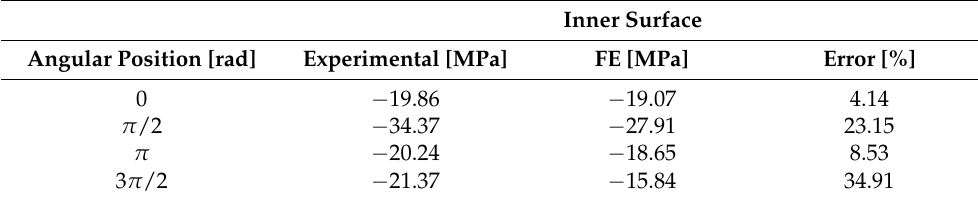
Table 6. Comparison of radial stress in the test boss.